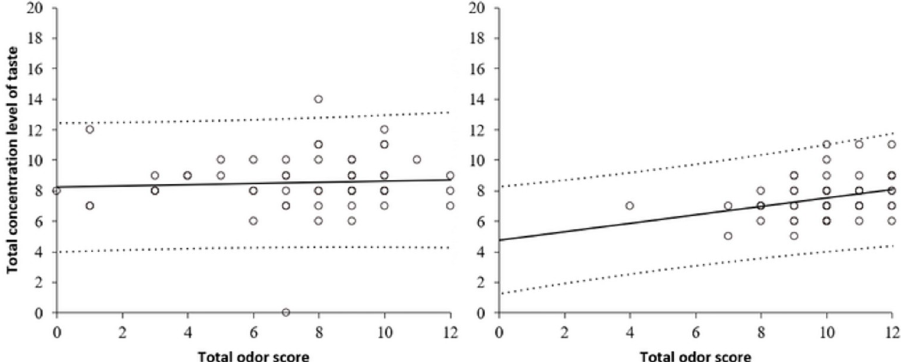
Fig 5. Linear fit between taste and olfaction in older adults (left) and young adults (right). The dots indicate data points, and dashed lines indicate the 95% prediction